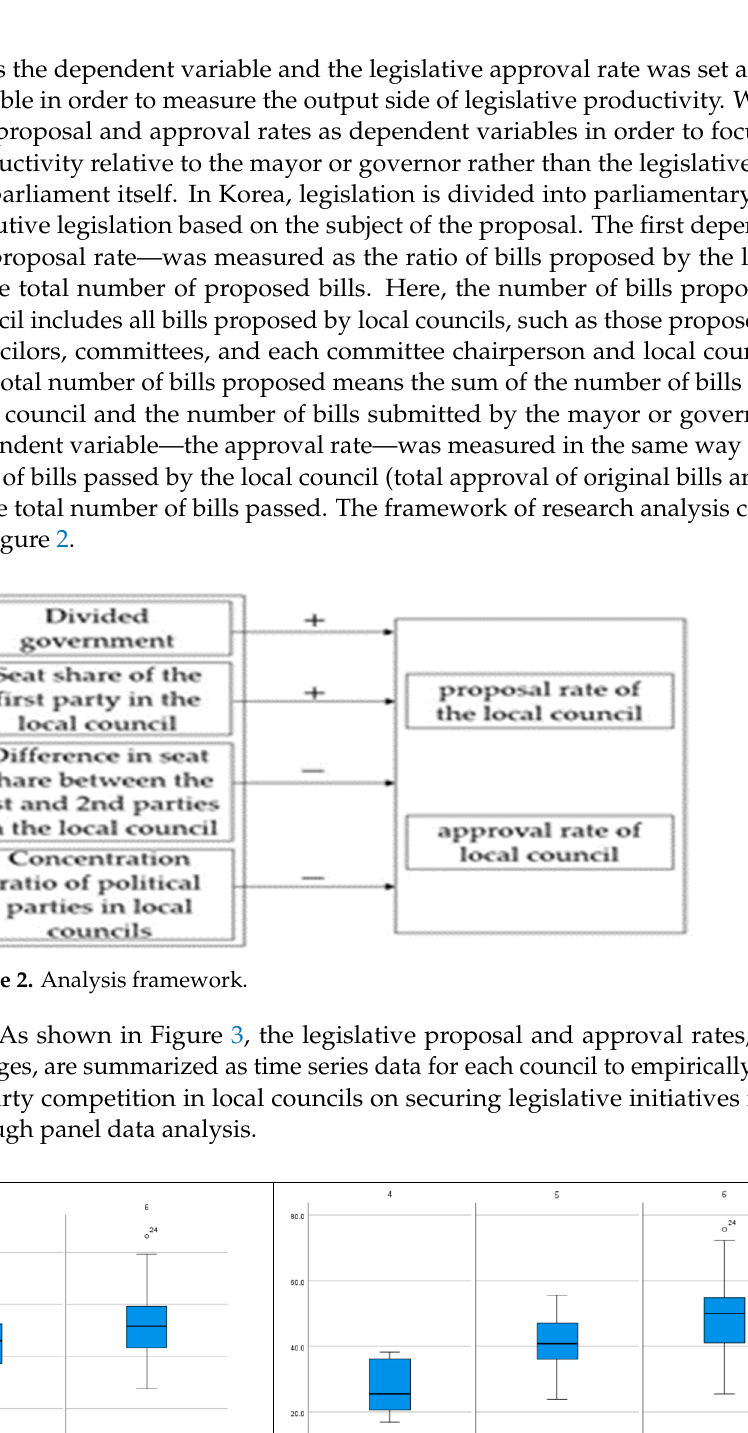
Figure 3. Proposal rate and approval rate transition of 15 local councils from the 4th to 6th terms.